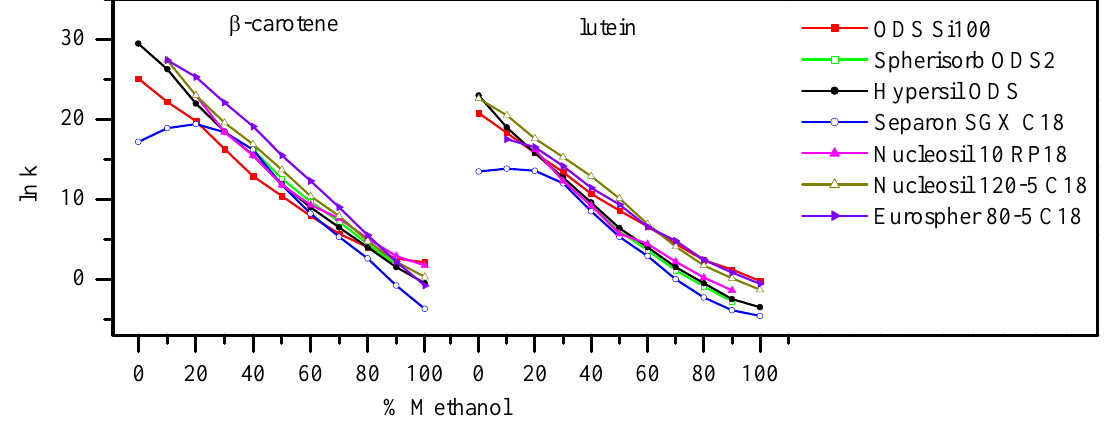
Figure 2. Calculated HPLC chromatograms of a model carotenoids mixture on Hypersil ODS and experimental chromatograms of a cherry tomato extract on Ultrasphere ODS.